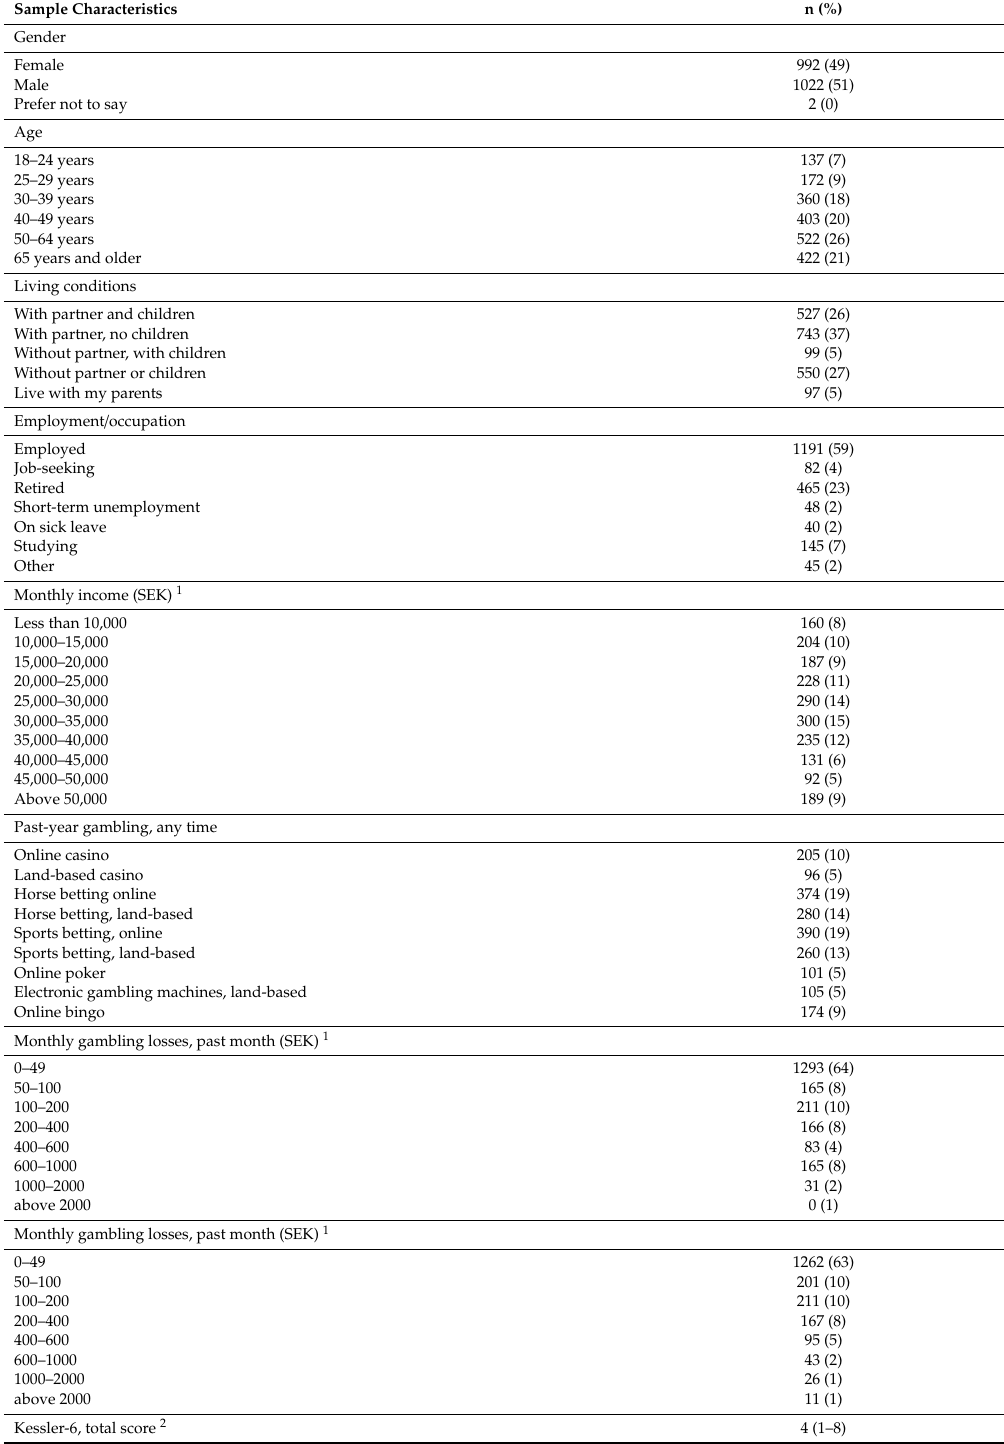
Table 1. Sample characteristics, all included individuals (N =